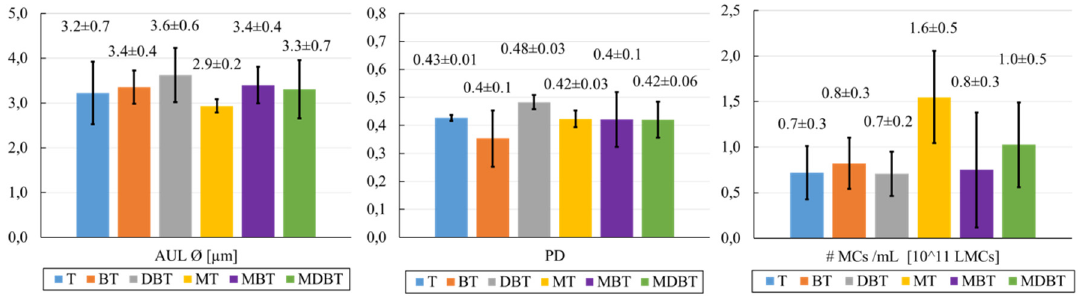
Figure 3. Active-to-active comparison of average upper limits (AUL) of Ø (left), polydispersities (PD) (centre) and yield (right), considering the mean values of three batches, for each parameter. Standard deviations are represented by error bars.